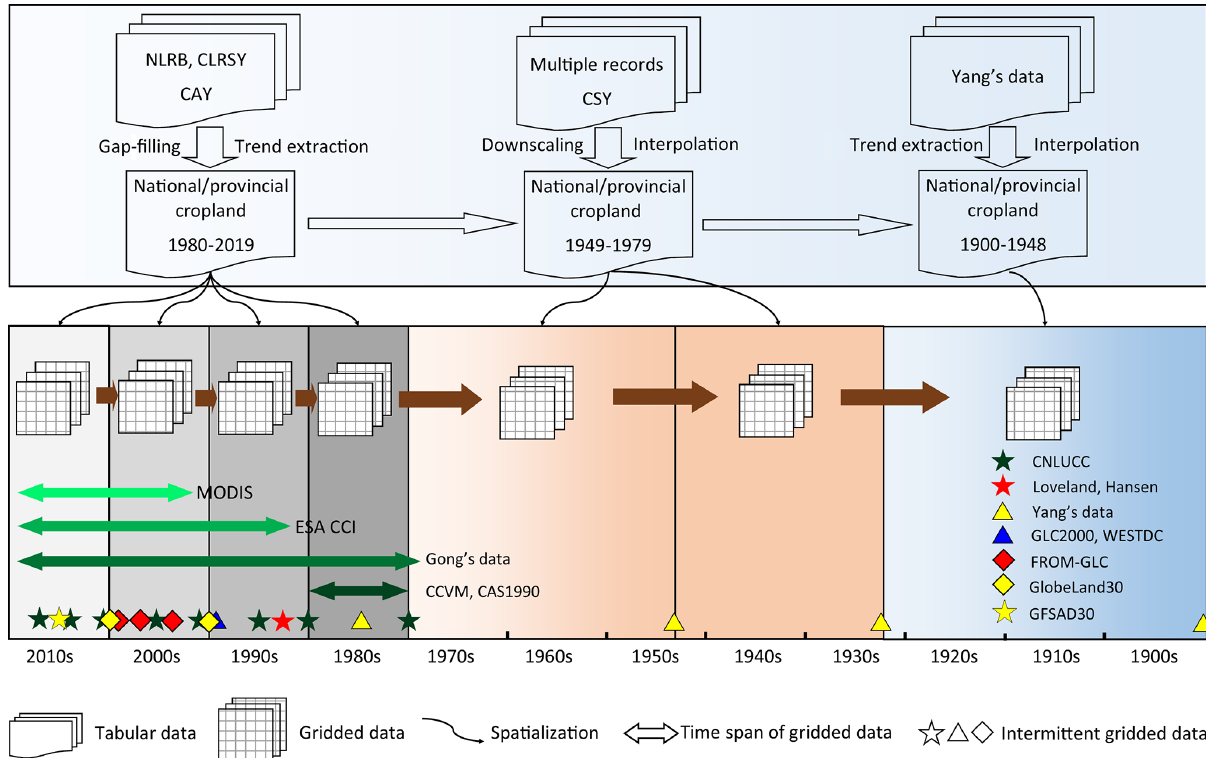
Figure 1. Methodology flow chart and datasets used in the cropland reconstruction. The upper boxes are the tabular survey data, and the lower boxes are the gridded images. The following abbreviations are used in the figure: CAY denotes the Chinese Agricultural Yearbook; CSY denotes the Chinese Statistical Yearbook; NLRB denotes the National Land and Resources Bulletin; CLRSY denotes the China Land and Resources Statistical Yearbook; MODIS denotes the Moderate Resolution Imaging Spectroradiometer Land Cover Type Collection 6 (MCD12Q1); ESA CCI denotes the the European Space Agency (ESA) Climate Change Initiative Land Cover; Gong et al.’s data refers to human settlement (urban and rural) data from Gong et al. (2013); GFSAD30 denotes the Global Food Security Analysis-Support Data at 30m; CCVM represents a 1 : 1000000 vegetation map of China; CAS1990 denotes land cover data that originated from a 1 : 1000000 land use map produced by the Institute of Geographic Sciences and Natural Resources Research, Chinese Academy of Sciences; CNLUCC represents China Land Use and Cover Change; Loveland denotes the land cover map developed by Loveland et al. (2000); Hansen denotes a land cover map produced by Hansen et al. (2000); Yang’s data refers to cropland data from Yang et al. (2015b); GLC2000 denotes the Global Land Cover 2000 database from the Joint Research Centre of European Commission; WESTDC represents a land cover map compiled by the Chinese Academy of Sciences and edited by Ran (2013); FROM-GLC denotes land cover maps produced by Gong et al. (2013) from Tsinghua University; GlobeLnad30 denotes land cover maps produced by the Ministry of Natural Resources of China. Note that the map reconstructed in 1 year was used as the initial condition for the following year’s cropland